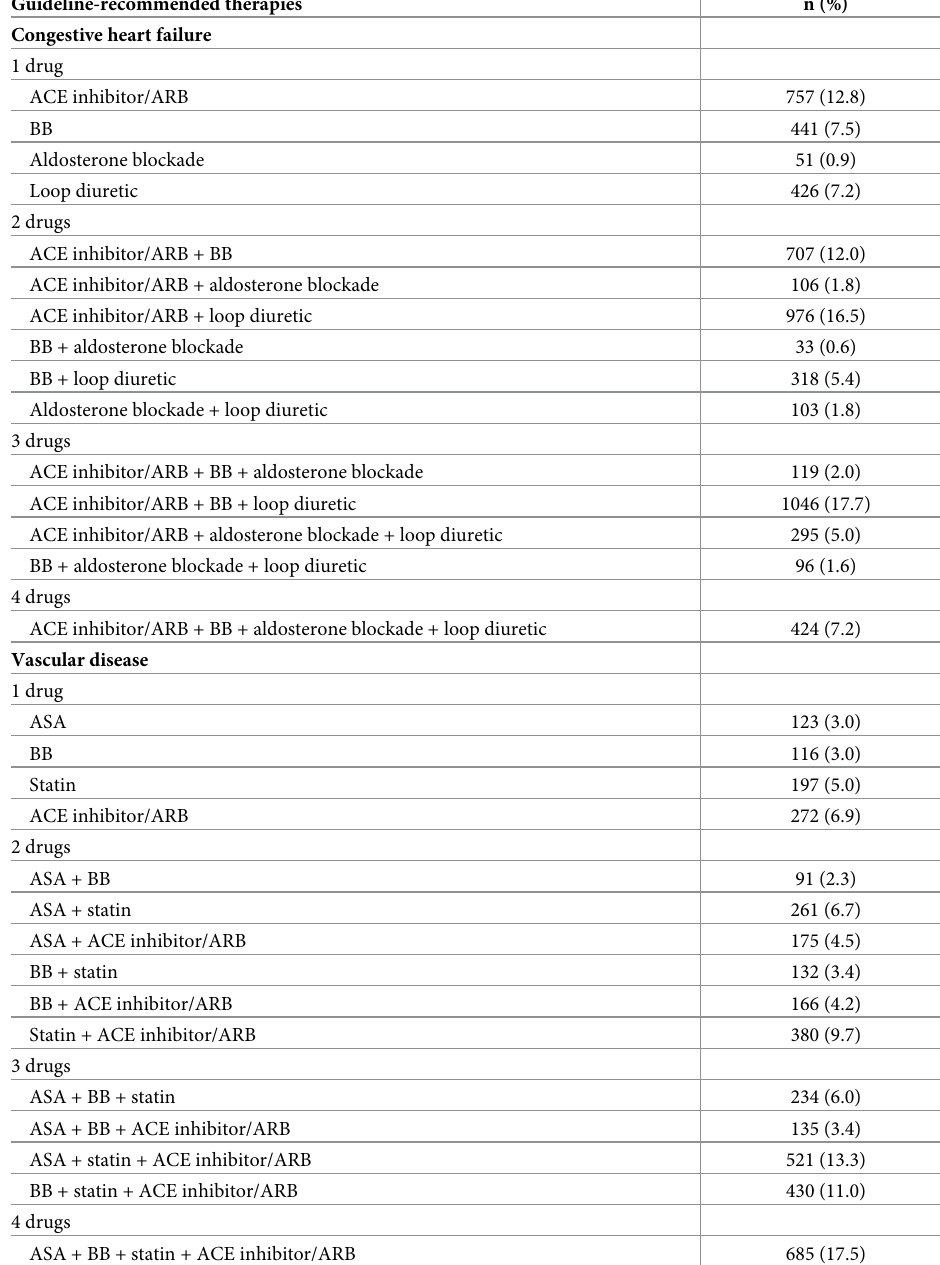
Table 3. Monotherapy and combinations of guideline-recommended therapies prescribed for patients with congestive heart failure or vascular disease. Guideline-recommended